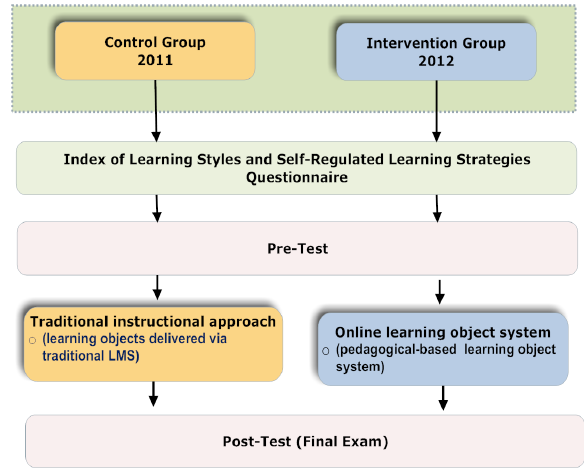
Figure 2. Flow of The Quasi-Experiment